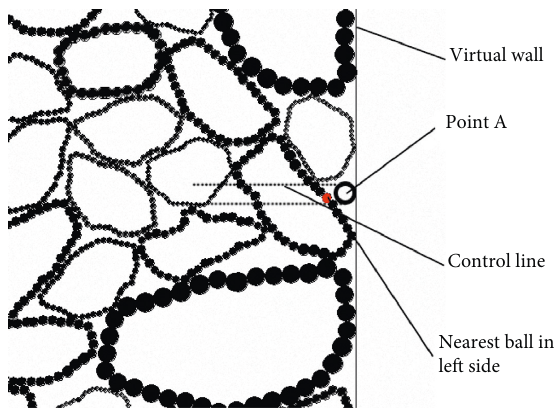
Figure 7: Distinguishing the position of mastic balls between the particle clump and the wall on the right side.